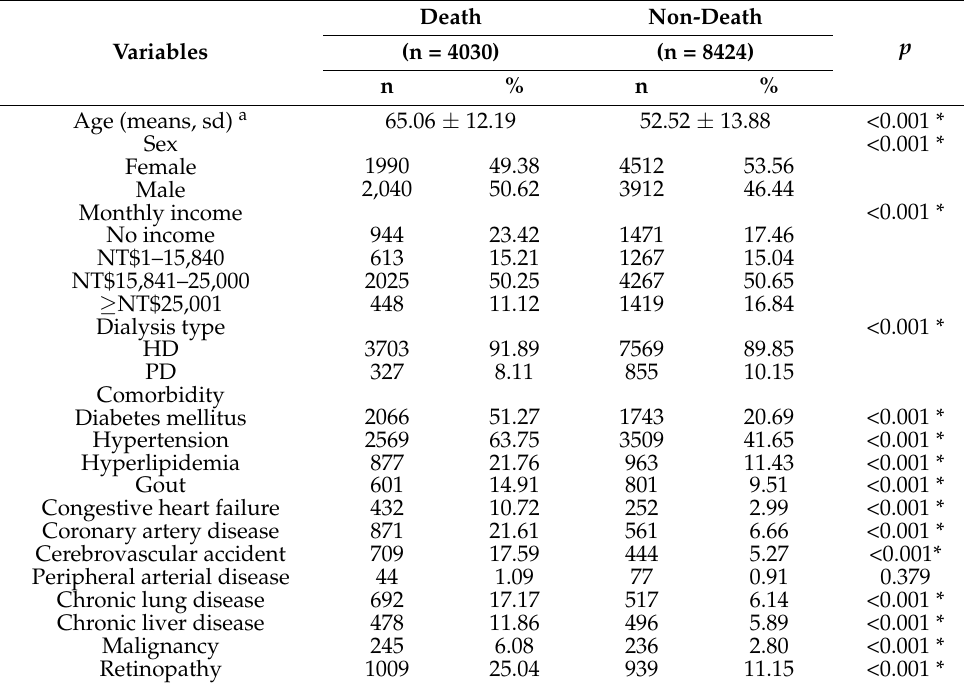
Table 2. Demographic characteristics of dialysis patients who died during 16